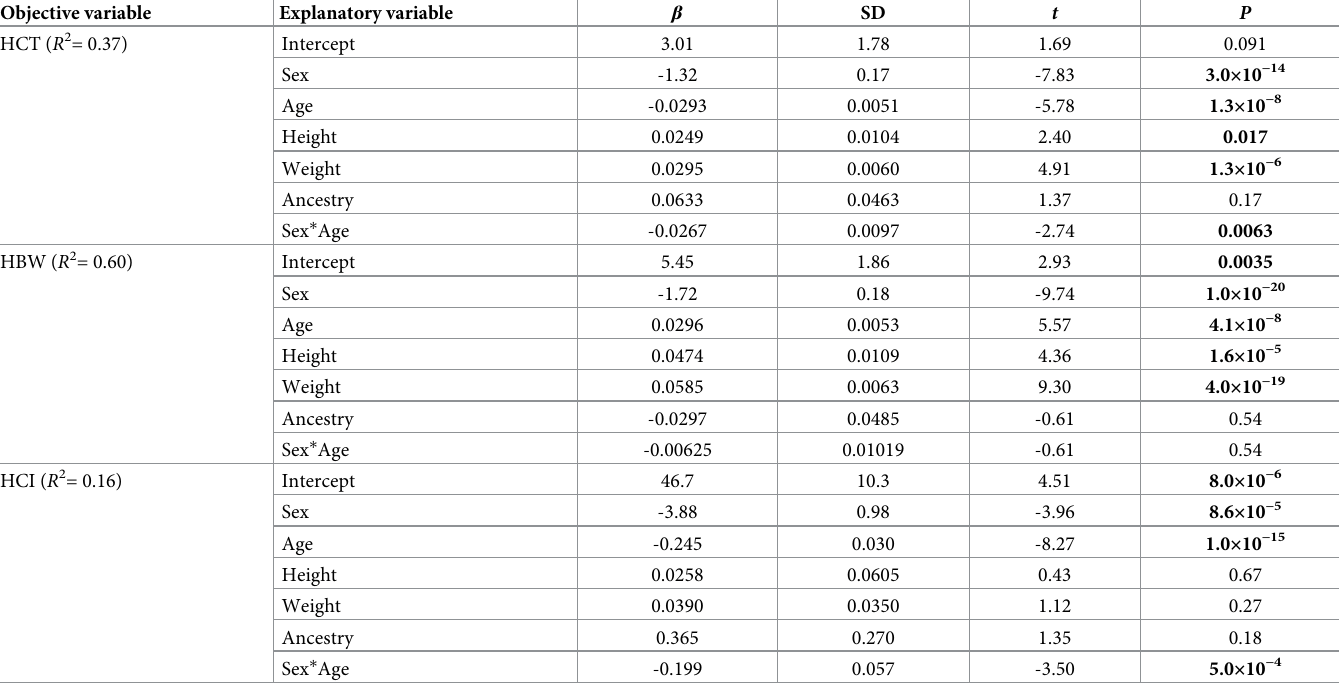
Table 3. Multiple regression analysis of humeral measurements.